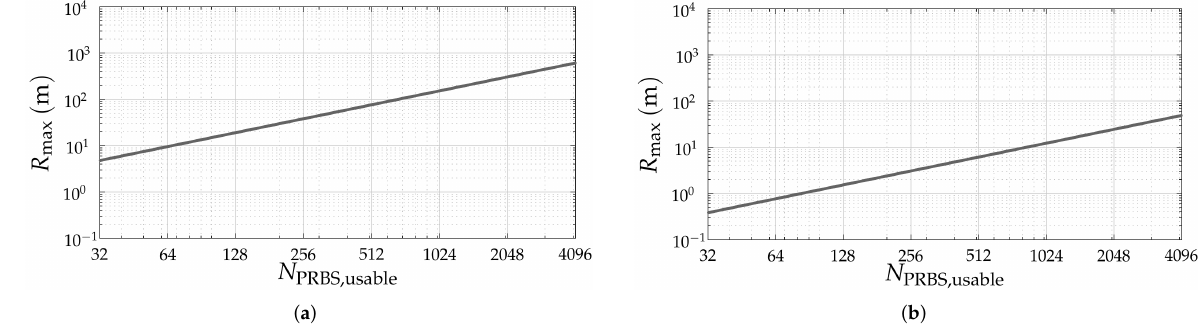
Figure 4. Maximum unambiguous range R max = N PRBS,usable ∆ R for the considered ( a ) automotive and ( b ) gesture recognition scenarios.